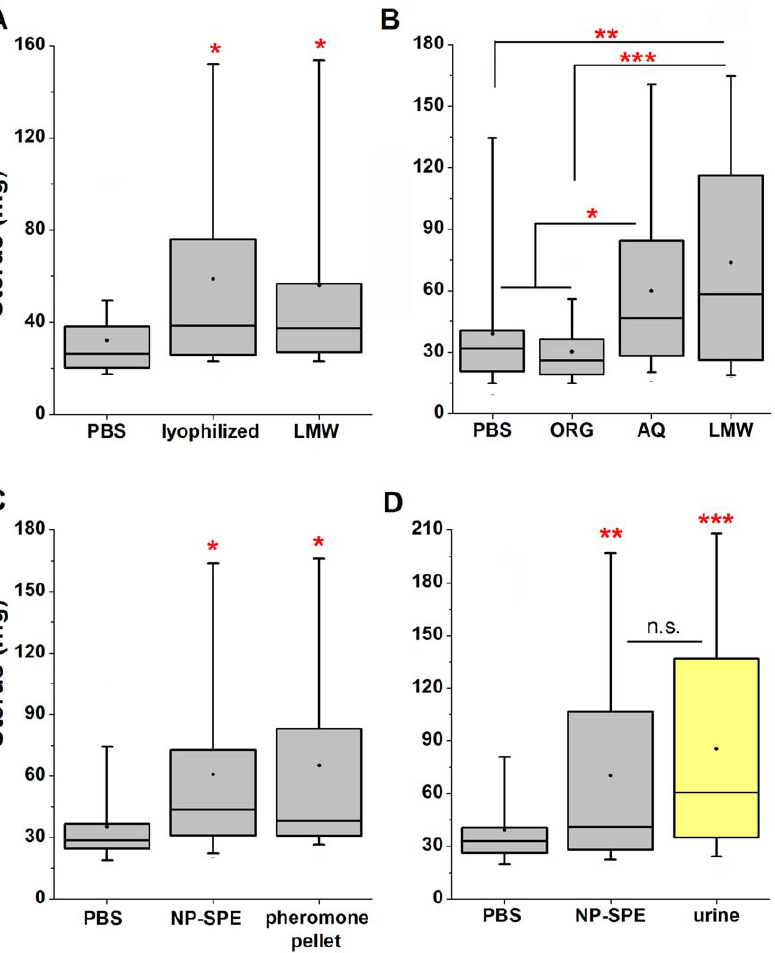
Figure 3. Fractionated bioactivity has biophysical characteristics that are inconsistent with known pheromones. ( A ) Lyophilization of LMW urine, to remove volatile urinary constituents, retains the bioactivity of a fresh LMW fraction (Dunnett’s). (End body masses are not significantly different, p=0.296). Averages of body mass (g): PBS, 17.90; lyoph LMW, 17.83; LMW, 17.50. n=21–23 per group. ( B ) Pheromones that increase uterine mass are not extracted into chloroform (ORG), they are retained in the aqueous phase (AQ) (Tukey’s HSD). (End body masses are not significantly different, p=0.313). Averages of body mass (g): PBS, 17.41; ORG, 17.29; AQ, 16.98; LMW, 17.29. n=20–35 per group. ( C ) Analysis of uterine weight folowing purification of the partially purified ‘‘pellet’’ by an NH 2 column using aqueous normal phase-solid phase chromotography (NP-SPE) (Dunnett’s). (End body masses are not significantly different, p=0.786). Averages of body mass (g): PBS, 17.46; NP-SPE, 17.58; pellet, 17.62. n=24–28 per group. ( D ) Comparison of retained bioactivity in NP-PSE fraction to total urine (Tukey’s HSD; indicated p values relative to PBS). (End body masses are not significantly different. P=0.783). Averages of body mass (g): PBS, 17.52; NP-SPE, 17.41; urine, 17.50. n=50–56 per group. PBS; phosphate buffered saline, LMW; low molecular weight urine size fraction. n.s., not significant, *p , 0.05, **p , 0.01, ***p ,